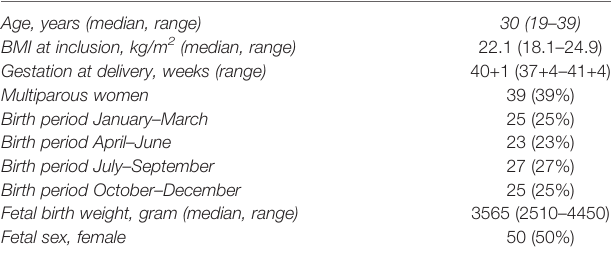
TABLE 1 | Characteristics of the participating women ( n